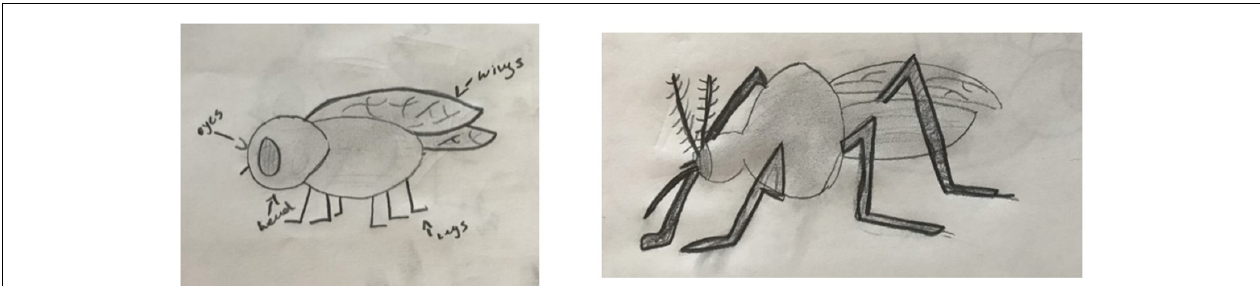
FIGURE 4 | Student illustration of a mosquito.